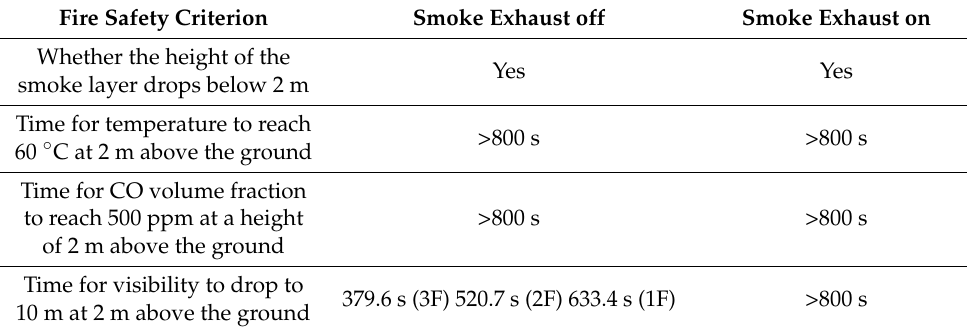
Table 5. Time required for each characteristic index to reach critical danger.